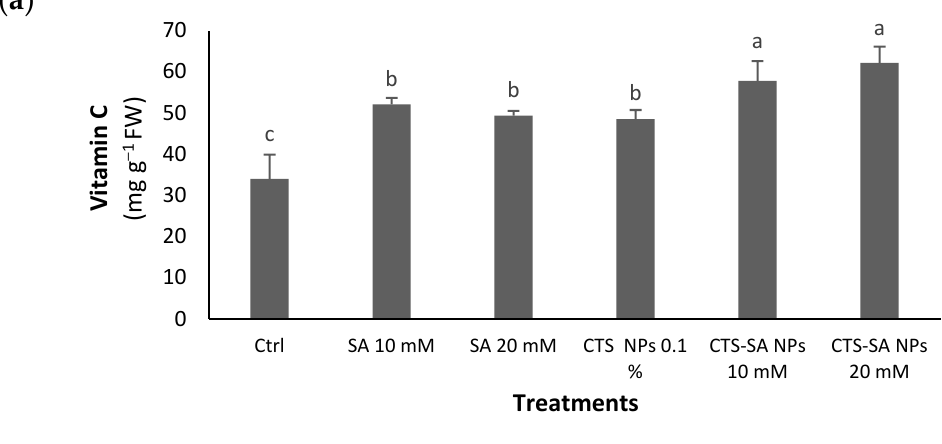
Table 1. The effect of salicylic acid (SA) (10 and 20 mM), chitosan (CTS) (0.1%), and their combina- tion in the nano-form (CTS-SA NPs) treatments on fresh (FW) and dry (DW) weights, titrable acidity (TA), total soluble solids (TSS), TSS/TA ratio, and pH of the grape ( Vitis vinifera L.) cv. Red Sultana. Different letters indicate significantly different values at p ≤